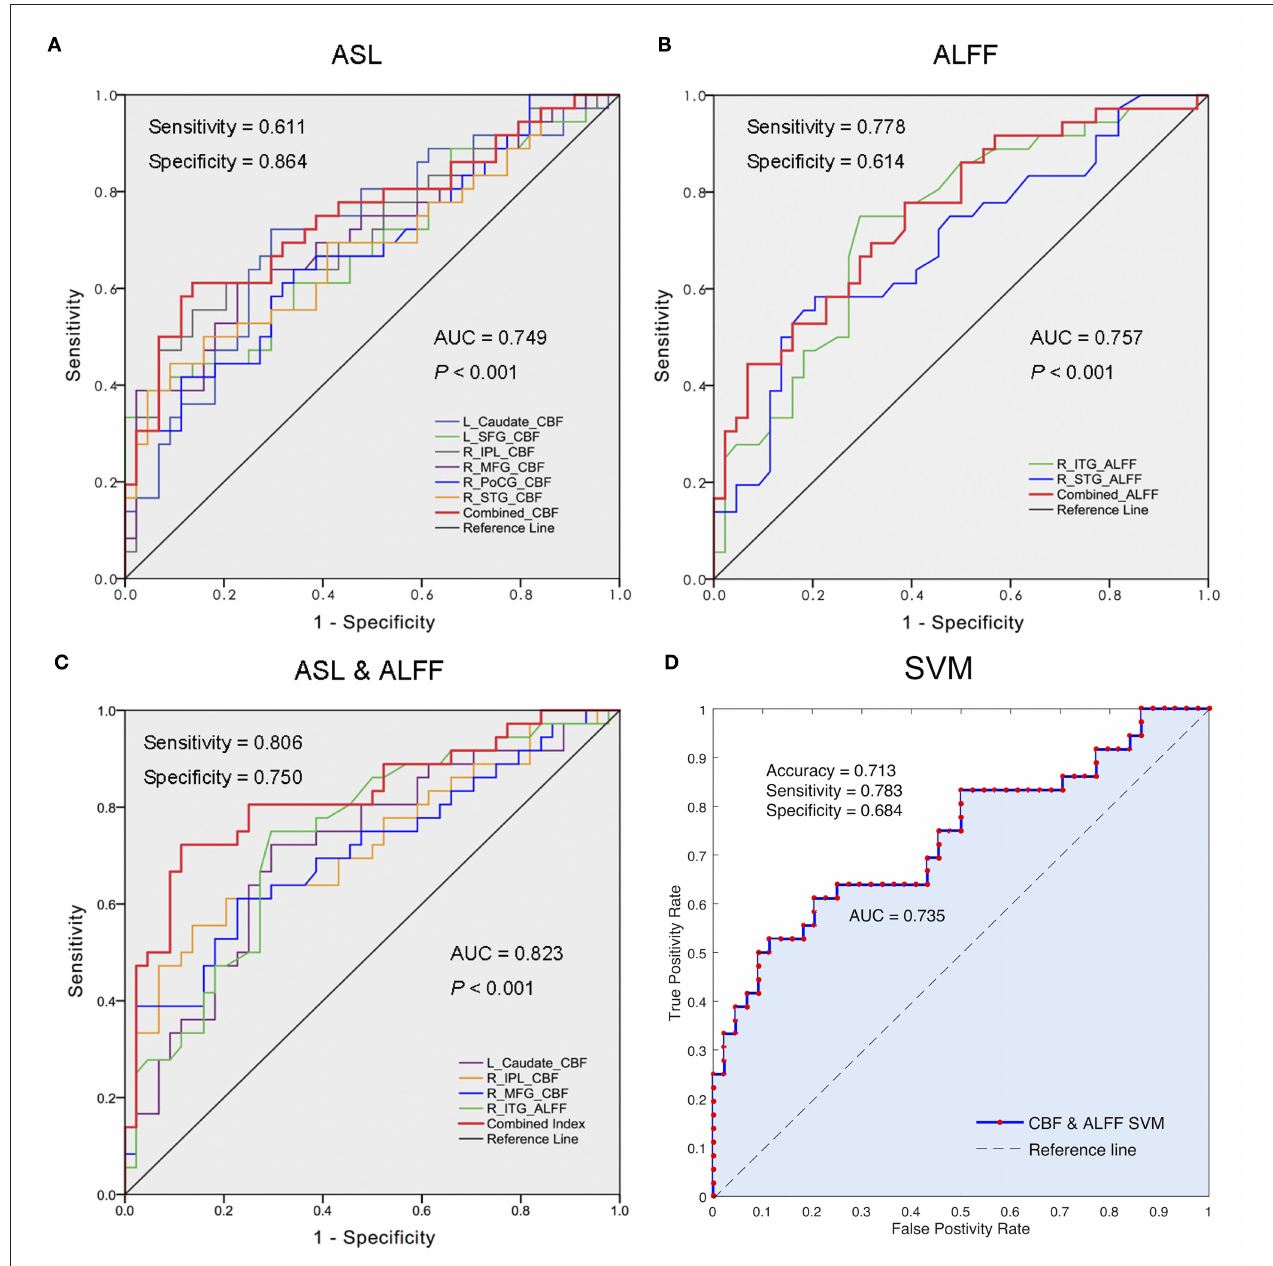
FIGURE 3 | Differentiation analyses using regional CBF, ALFF, and integrated bi-modal parameters. (A) The performance of changed CBF values in differentiating the NRD from RD; (B) the performance of altered ALFF values in segregating the NRD from RD; (C) the optimal performance of the combination of changed CBF and ALFF values in distinguishing the NRD from RD; (D) the accuracy of the combined eight features (the CBF in L_caudate nucleus, R_SFG, R_IPL, R-MFG, R_STG, and R_PoCG, as well as the ALFF in R_STG and R_ITG) using 10-fold cross-validation SVM classifier. ROC, receiver operator characteristic; NRD, non-responsive depression; RD, responsive depression; AUC, area under the curve; CBF, cerebral blood flow; ALFF, amplitude of low-frequency fluctuation; L, left; R, right; SFG, superior frontal gyrus; IPL, inferior parietal lobule; MFG, middle frontal gyrus; PoCG, postcentral gyrus; STG, superior temporal gyrus; ITG, inferior temporal gyrus; SVM, support vector machine.